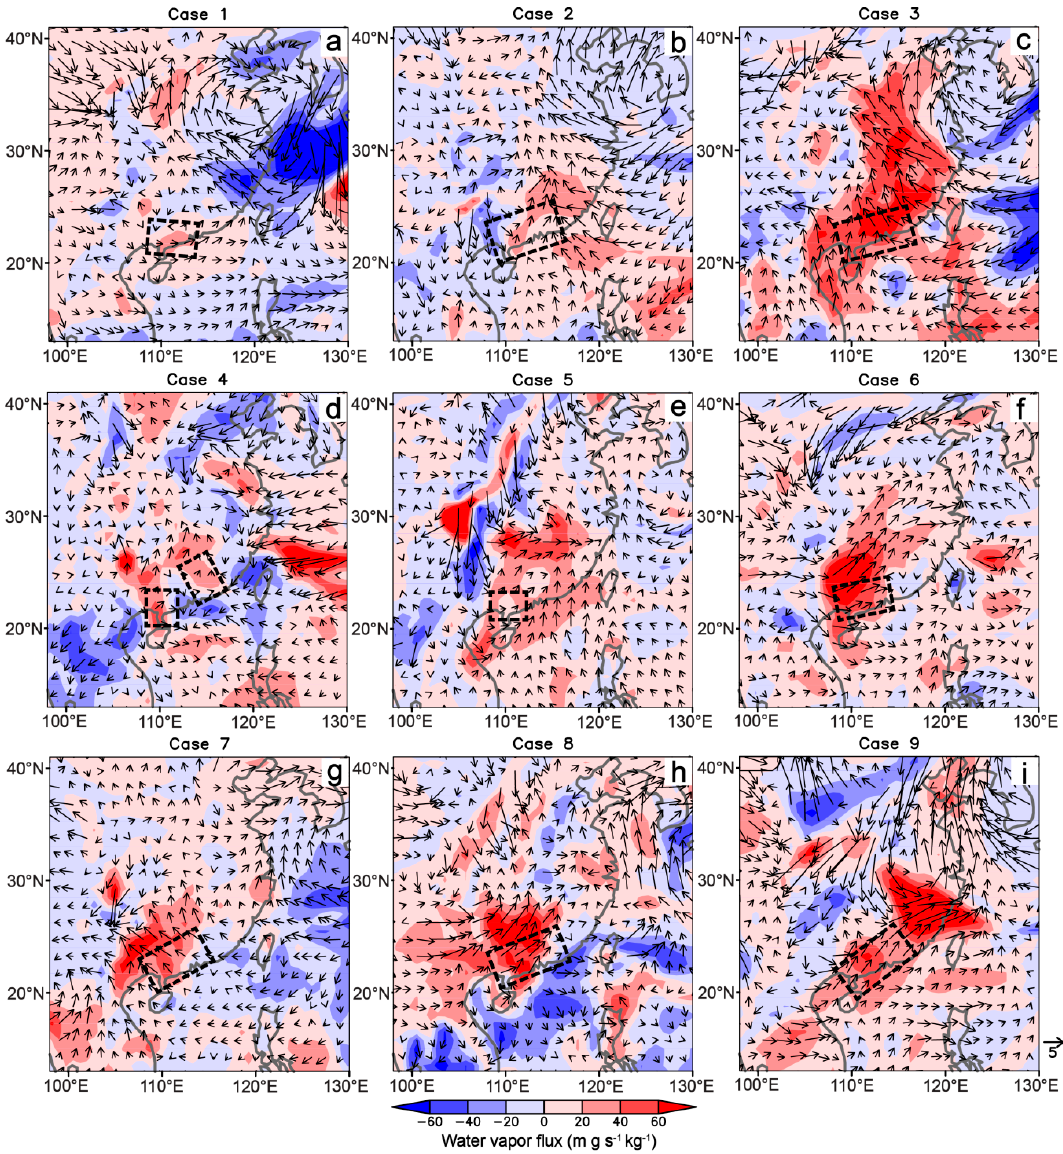
Figure 6. Distributions of low-level water vapor flux (color-shaded; units: m g kg − 1 s − 1 ) and wind vector (units: m s − 1 ) increments for cases 1–9 ( a – i ) when MCSs turned to move southeastward. The levels for a – i are 775, 850, 900, 900, 850, 800, 900, 975 and 750 hPa, respectively. The differences for a – i are calculated by the fields at 1400 BT 11 April 2012, 0800 BT 6 April 2014, 2000 BT 8 May 2014, 0800 BT 23 May 2014, 0800 BT 1 May 2015, 1400 BT 5 May 2015, 2000 BT 4 April 2016, 1400 BT 15 April 2016 and 1400 BT 19 April 2017 subtracting those 6 h earlier, respectively. The dashed rectangles indicate the locations of the